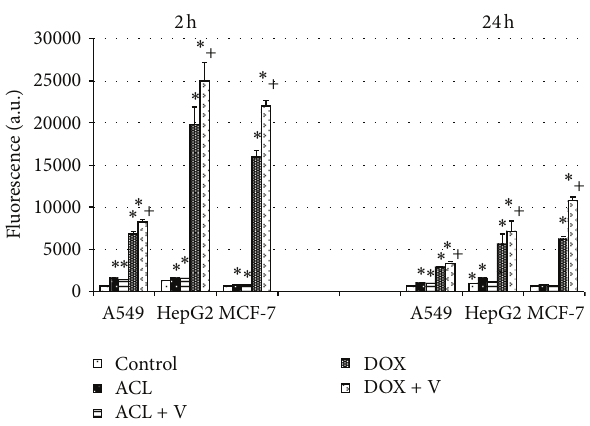
Figure 2: The effect of Verapamil on ACL and DOX accumulation in tested cells. The accumulation of ACL and DOX in A549, HepG2, and MCF-7 cell lines was examined after 2h incubation with IC 50 of the drugs and 24 h after incubation without drugs. The excitation = 436 nm and 𝜆 = and emission wavelengths were for ACL 𝜆 ex ex = 488 nmand 𝜆 = 566 ,respectively. ∗ Values 585 nmandDOX 𝜆 ex em are statistically significant in comparison to the control, untreated cells, 𝑃 < 0.05 . + Values are statistically significant in comparison to the cells incubated without Verapamil, 𝑃 < 0.05